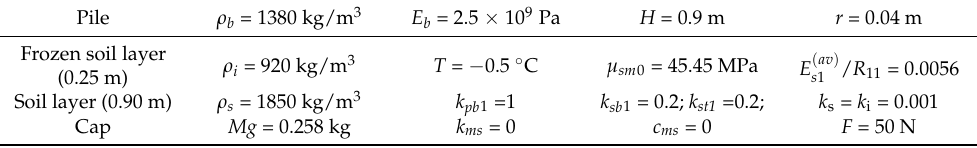
Table 1. Model test parameters of the pile–soil–cap system.